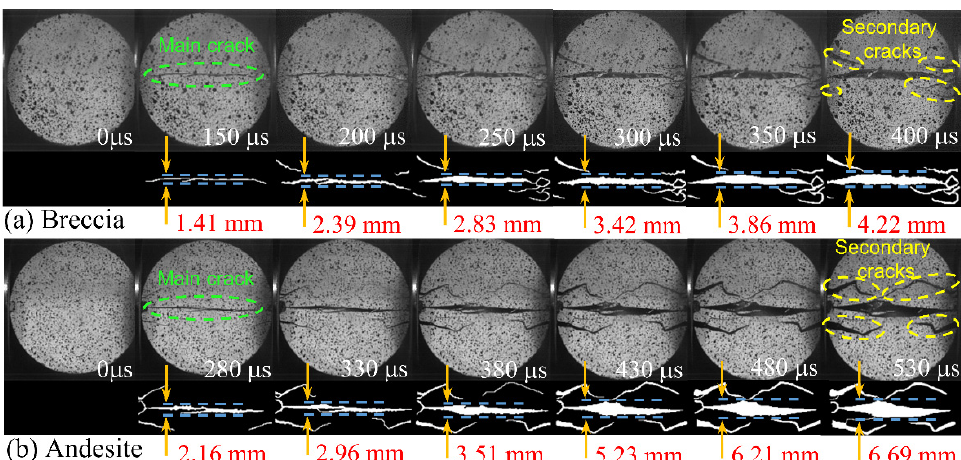
Figure 8. Images of the fragmentized process and main crack width at different moments: ( a ) Breccia specimen at 4.86 m/s striking velocity; ( b ) Andesite specimen at 4.88 m/s striking velocity.